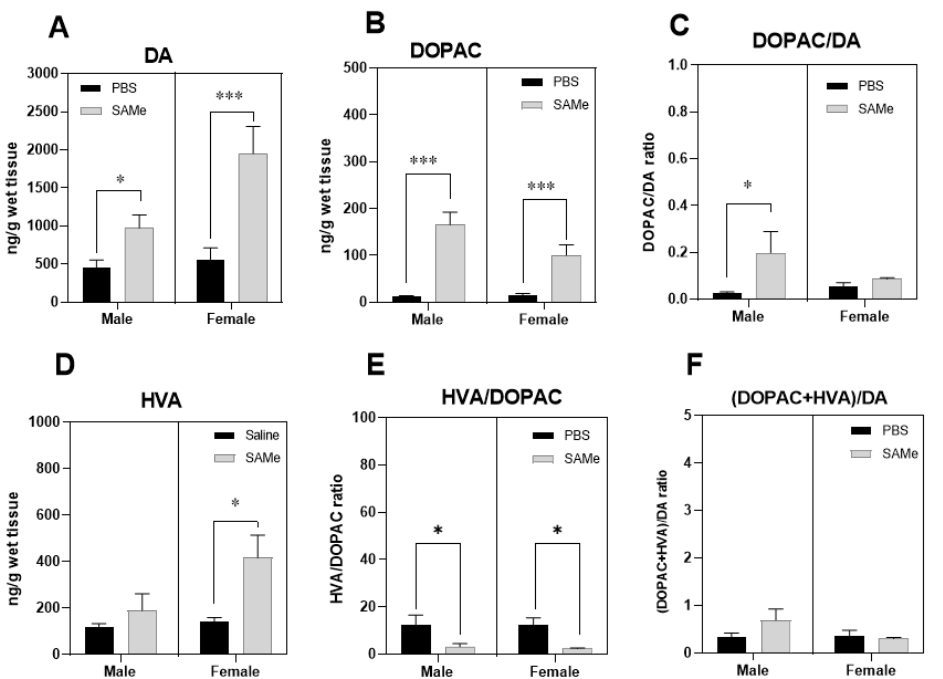
Figure 2. SAMe effects on dopamine metabolism in the PFC. SAMe treatment significantly elevated the level of dopamine ( A ), and of DA catabolic product-DOPAC ( B ) in the PFC of Sub male and female mice and lead to prominent increase in DOPAC/DA index only in male PFC ( C ). SAMe treatment also induced higher levels of HVA ( D ), the end product of DA degradation only in females and decreased HVA/DOPAC index in both genders ( E ). However, the overall turnover of DA was unchanged ( F ). The data are presented as mean ± SEM. Levels of DA, DOPAC and HVA are presented in ng/g tissue, n ≥ 6 for each group. *** p < 0.001; * p < 0.05 compared to control mice of the same gender.